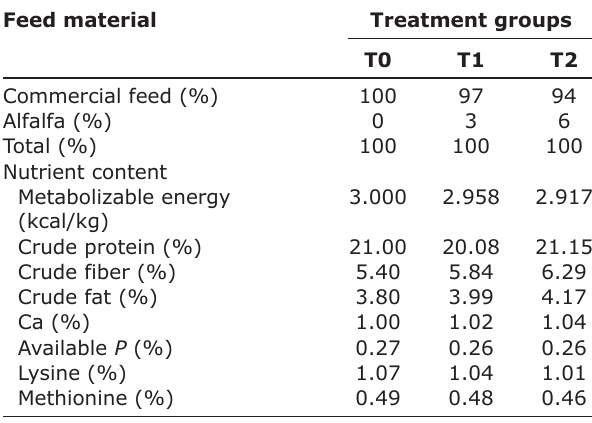
Table-1: Nutritional content of the hybrid duck